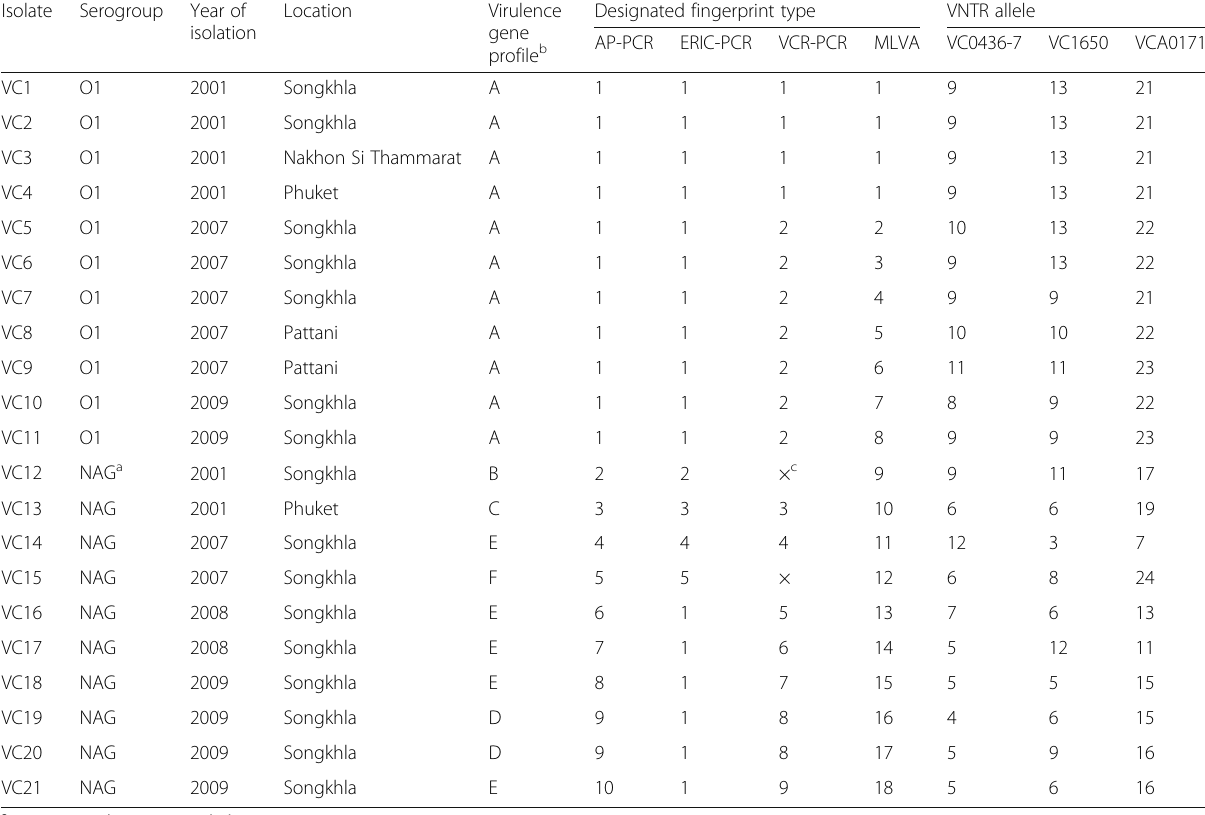
Table 1 Details of V. cholerae isolates used and their molecular characteristics Isolate Serogroup Year of